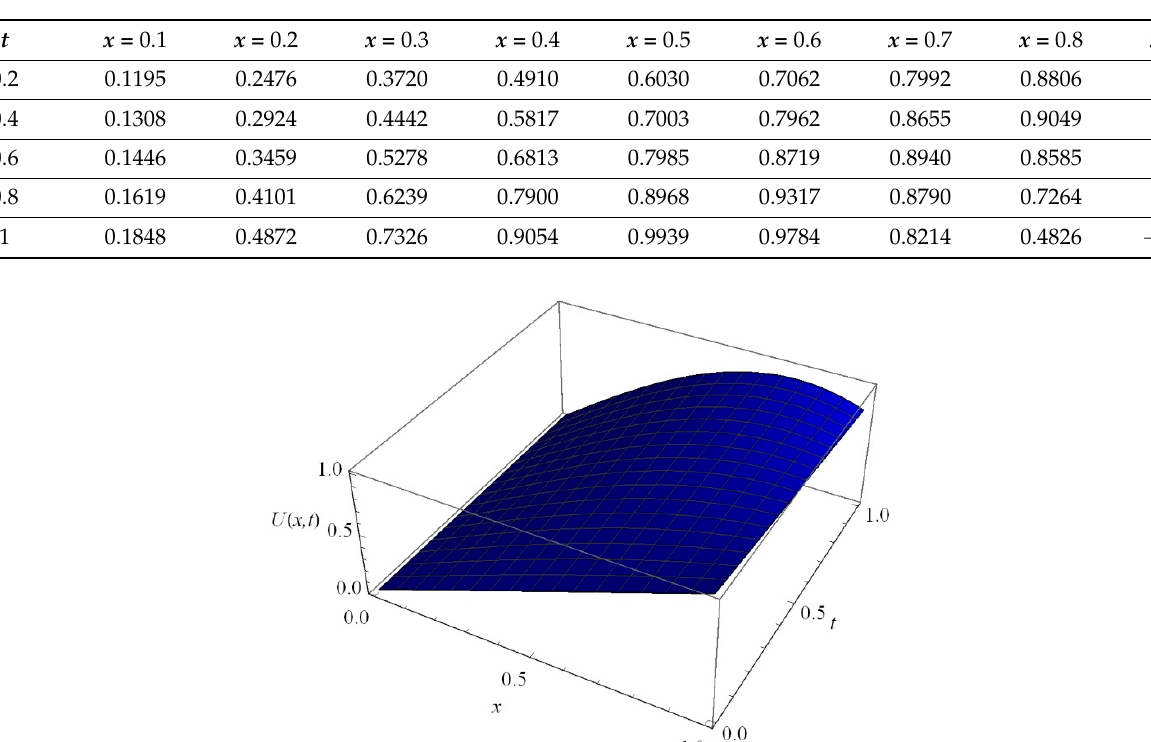
Table 3. Numerical values of moisture content U ( x , t ) .